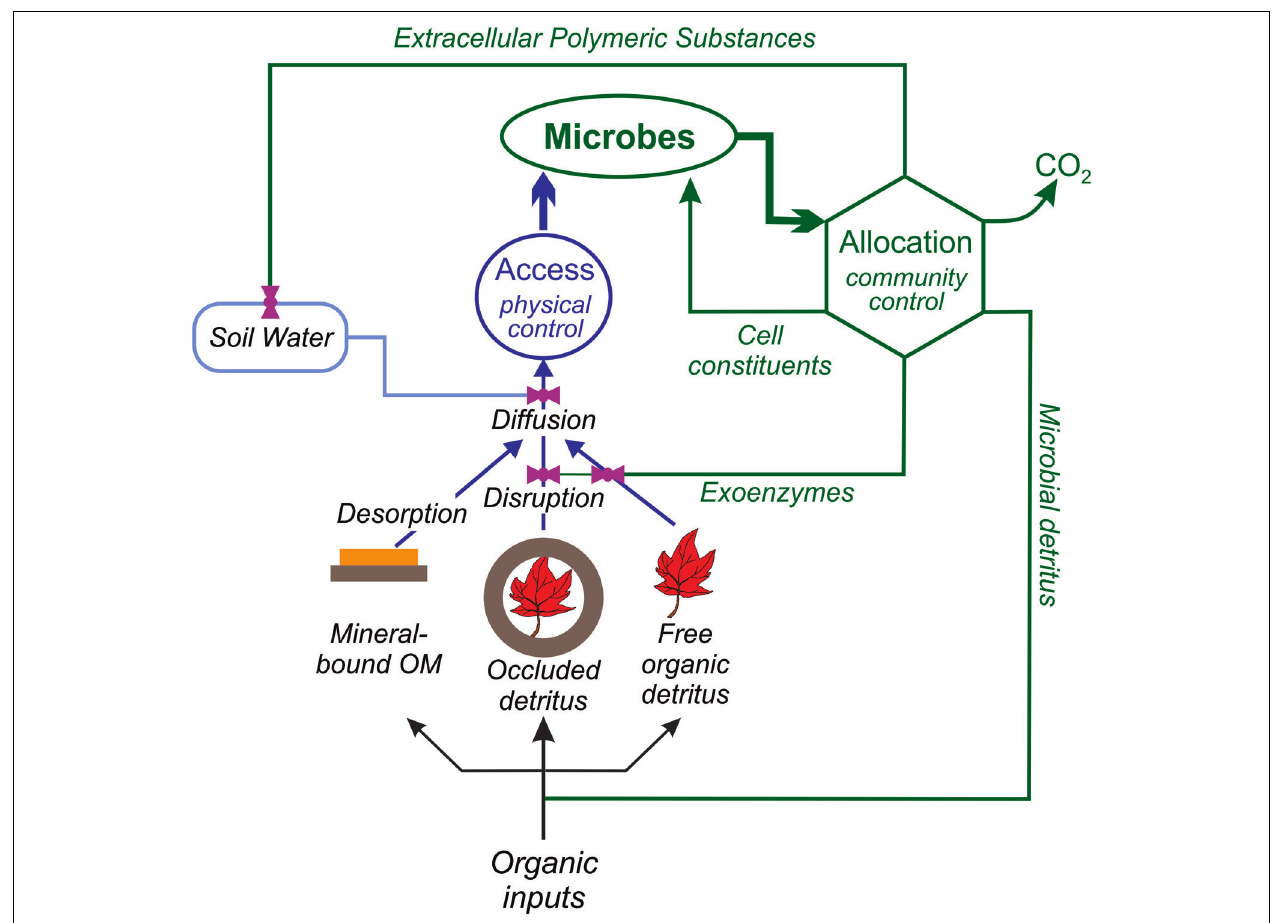
FIGURE 1 | Microbial C cycling: the relative roles of physical access to soil C pools and of microbial allocation patterns in regulating overall soil C dynamics.